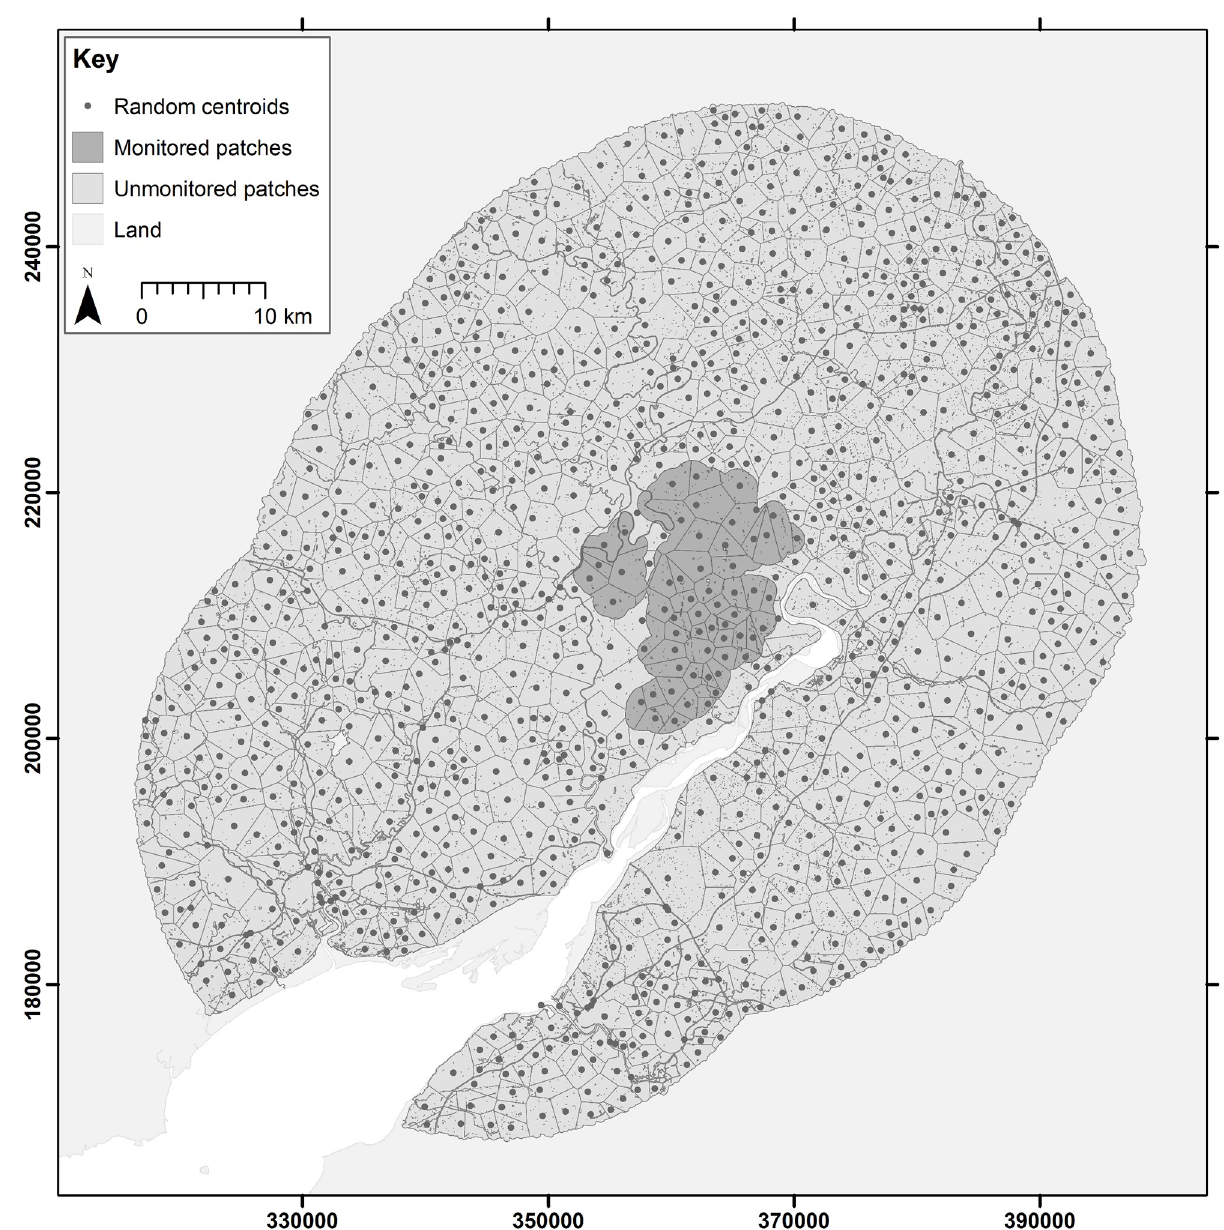
Fig 1. Map of study extent around the Forest of Dean. Model considers a 25 km buffer around the forest estate separated into two regions: that currently monitored (shaded) and that unmonitored (unshaded). Each of these regions are divided into randomised patches of approximately 4 km 2 .